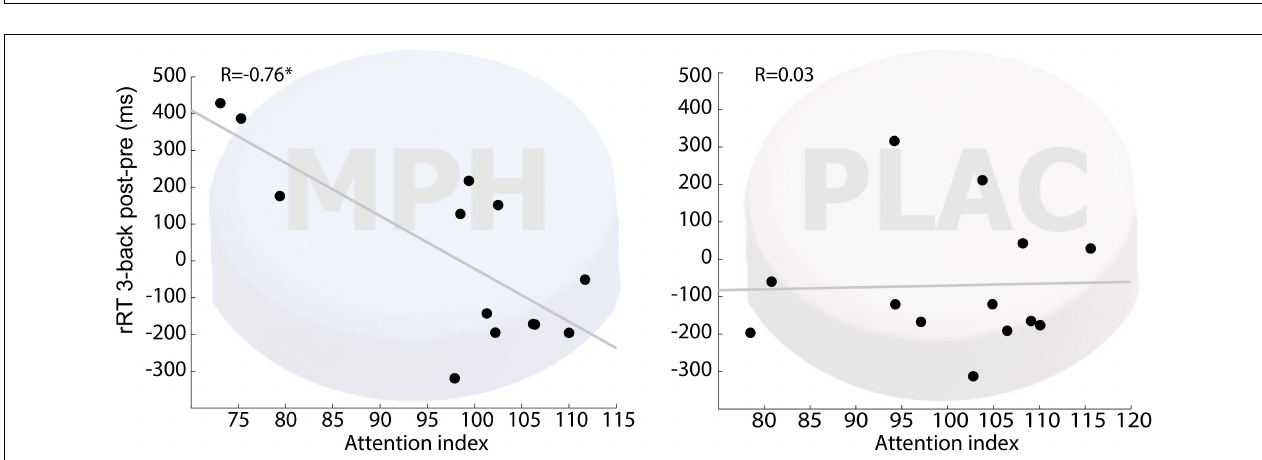
FIGURE 2 | Cognitive load effect on brain activity. (A) Group brain activation maps ( n = 13) for 3-back vs. 0-back are shown in sagittal coronal and axial views (random effects, p < 0.01, FDR corrected). The a priori selected ROI in the rDLPFC is marked by white boundaries. (B) Activity in the rDLPFC shows similar cognitive load-effect for pre- and post drug administration across induction conditions. Error bars stand for Standard Error of the Mean. * p < 0.001.